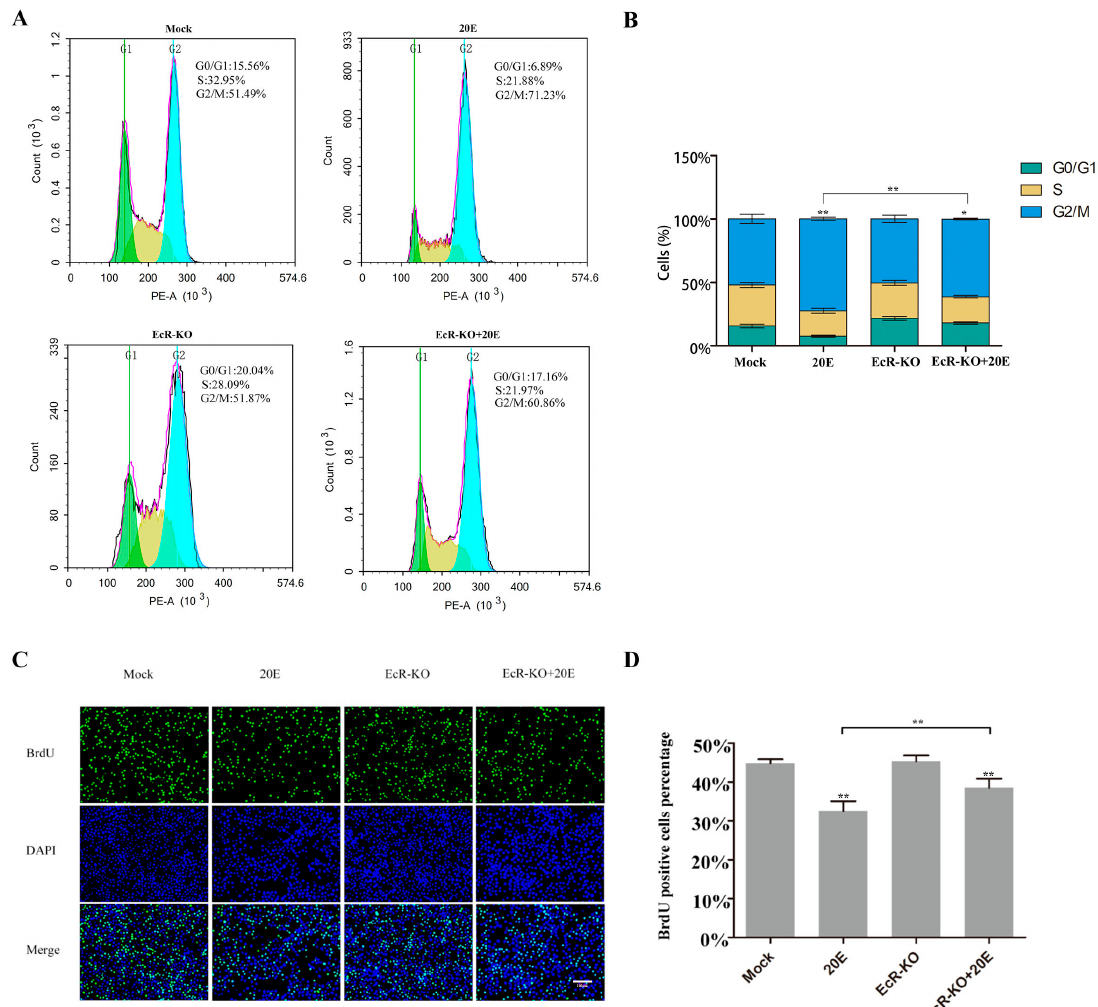
Figure 2. 20E can regulate the cell cycle through BmEcR in BmN-SWU1 cells. ( A ) Cell cycle analysis of BmN-SWU1 cells incubated with 0.25 µ g / mL 20E for 24 h after transfection with Cas9-BmEcR sgRNA recombinant plasmid (EcR-KO) or Cas9-Mock plasmid. ( B ) Statistical analysis of the cell percentage of each phase, including G0 / G1, S, and G2 / M phases (* p < 0.05, ** p < 0.01). ( C ) Anti-5-bromodeoxyuridine (anti-BrdU)-labeled BmN-SWU1 cells incubated with 0.25 µ g / mL 20E for 24 h after transfection with Cas9-BmEcR sgRNA recombinant plasmid (EcR-KO) or Cas9-Mock plasmid. Nuclei were stained with DAPI. Scale bars, 100 µ m. ( D ) Ratio of positive cells labeled with BrdU (* p < 0.05, ** p < 0.01).